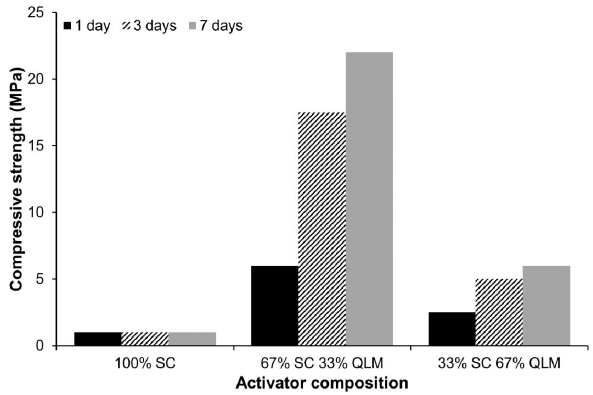
Figure 1: Effect of calcium oxide content on compressive strength (adapted from